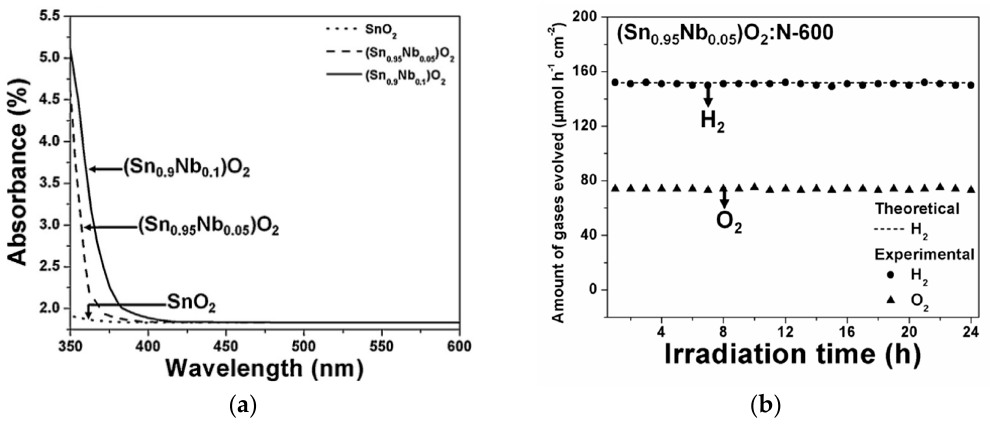
Figure 12. ( a ) UV/vis absorption spectra of SnO 2 NTs and (Sn 1 − x Nb x )O 2 NTs (x = 0.05, 0.1) and ( b ) theoretical H 2 gas and measured H 2 and O 2 gases, during 24 h chronoamperometry test of (Sn 0.95 Nb 0.05 )O 2 /N performed in 0.5 M H 2 SO 4 solution at 0.75 V (vs. RHE) and 26 °C. Reproduced with permission from the authors of [70]. Copyright (2019), Elsevier, Amsterdam, Netherlands.